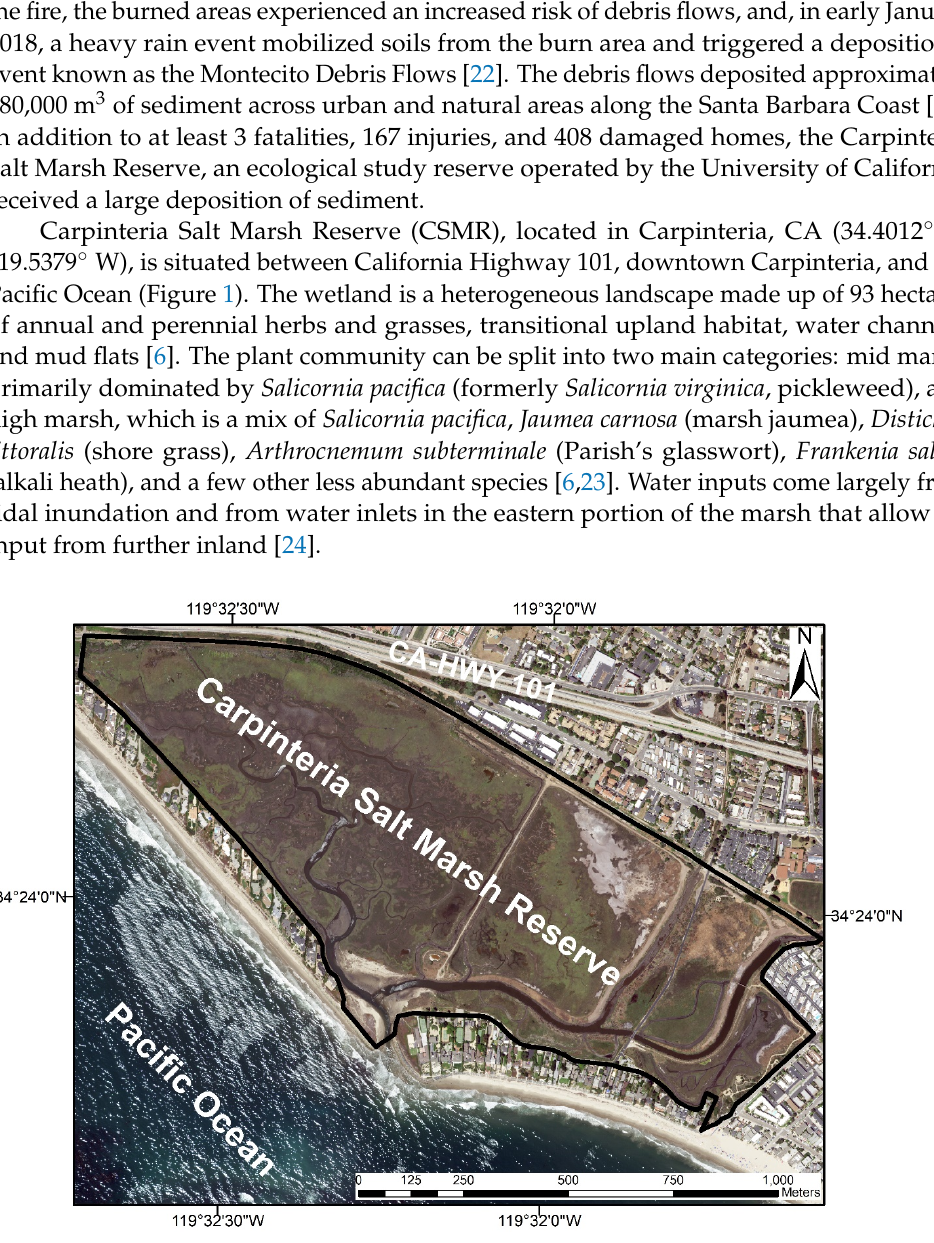
Figure 1. Carpinteria Salt Marsh Reserve with study extent outlined. Imagery courtesy of USDA National Agriculture Inventory Program.